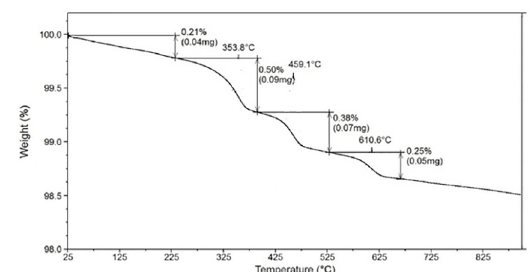
Figure 5. Thermogravimetric analysis of the calcium phosphate